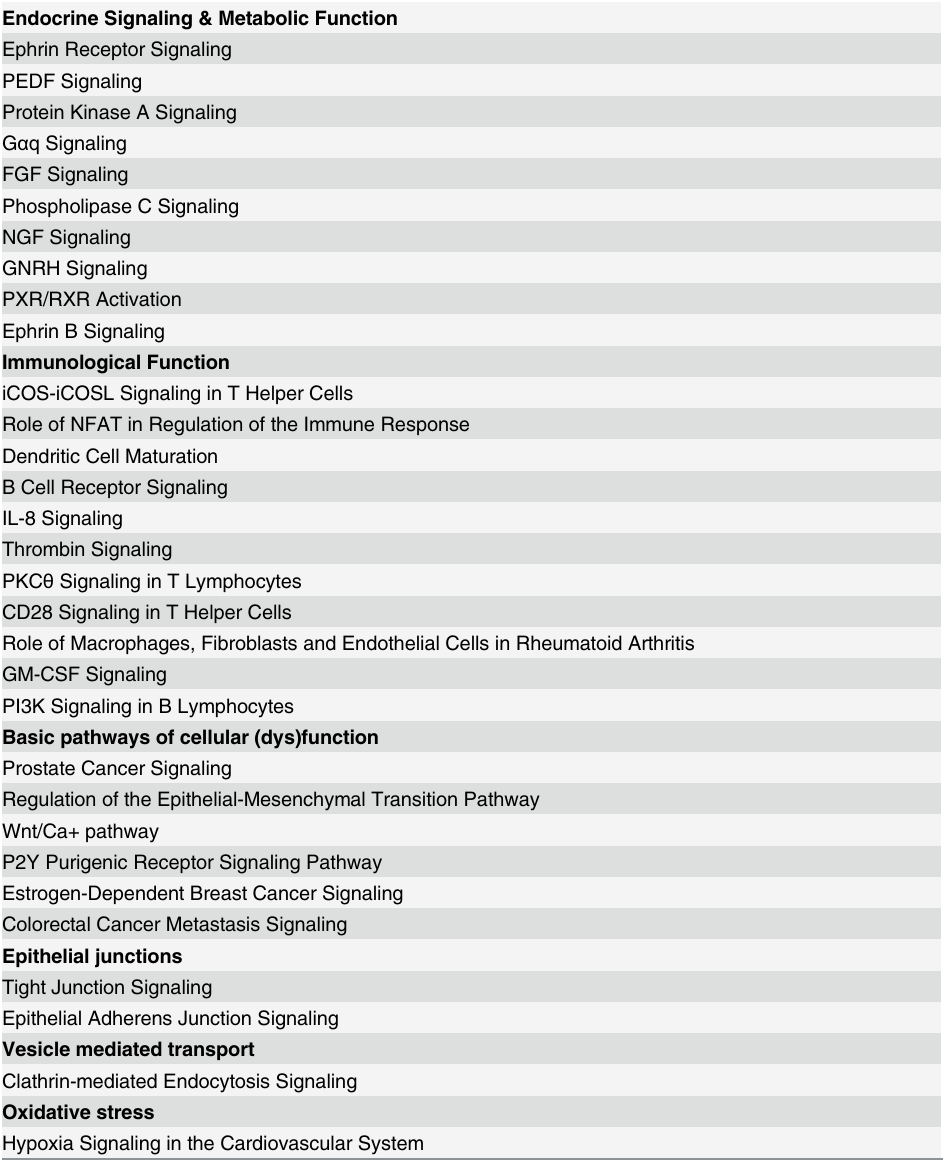
Table 4. Overview of significant canonical pathways assigned by the Ingenuity knowledge database to the 101 genes that are the result of comparing the “ Mouse high RPE gene expression ” and the “ Human very low RPE gene expression ”